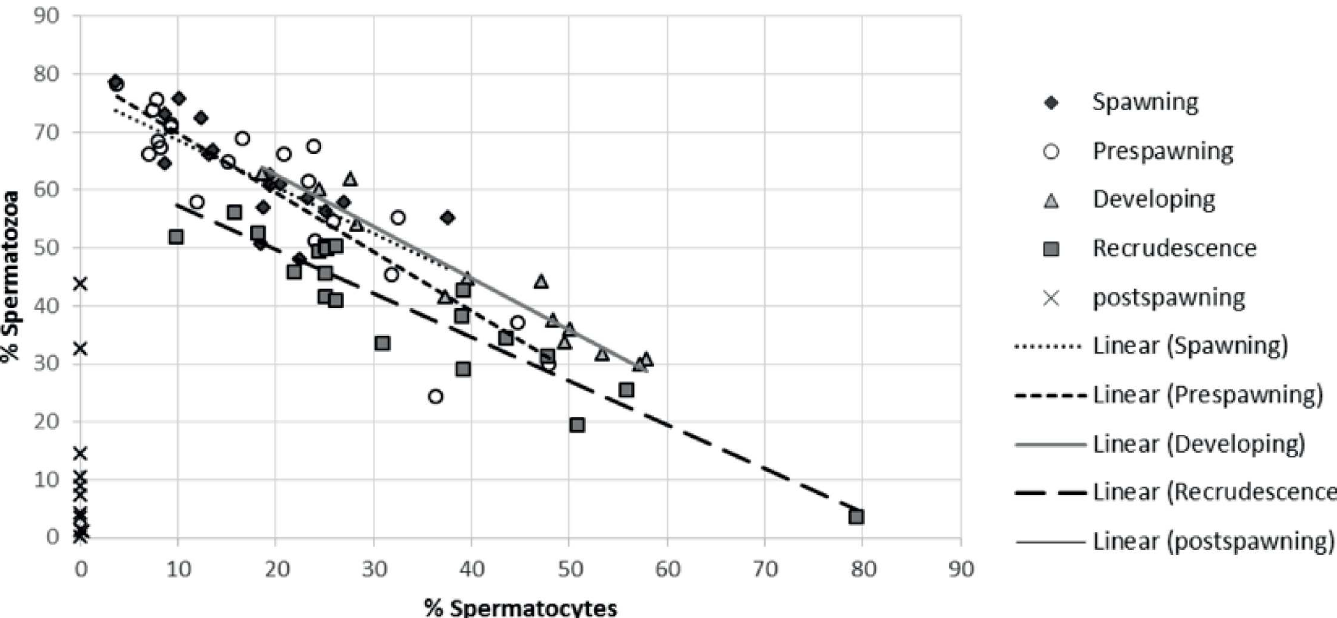
Fig 4. Linear regression between the percent of spermatozoa and the percent of spermatocytes. The equationsof the trend lines are for four of the different stages of the annualcycle; recrudescence: y = -0.7566x+ 64.882, R 2 = 0.8791; developing:y = -0.895x + 80.694, R 2 = 0.934 pre-spawning: y = -1.0205x + 80.027; R 2 = 0.7977; and spawning: y = -0.803x + 76.75, R 2 = 0.5874. Post-spawning fish were taken out of this analysisbecausethey do not have the spermatozoacell type.